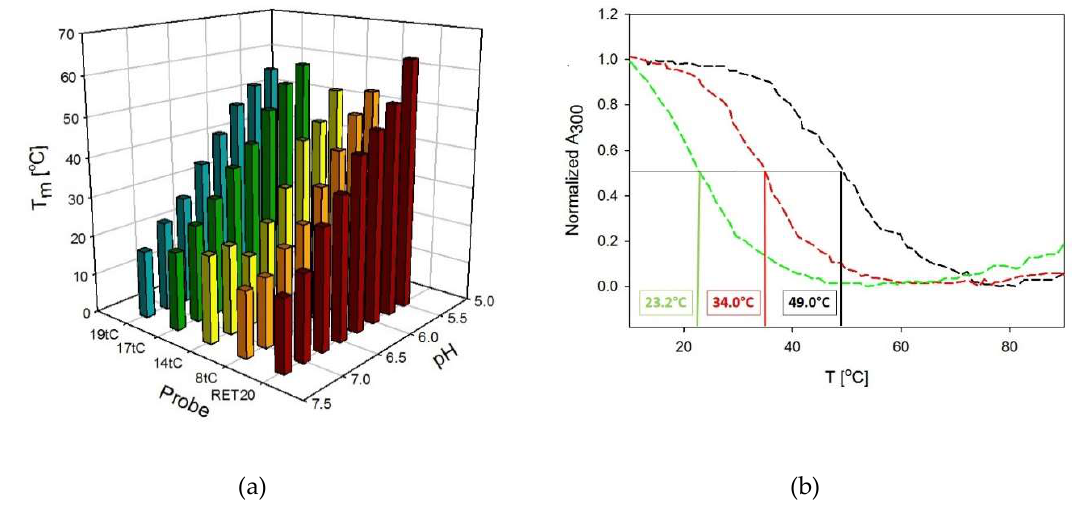
Figure 2. ( a ) Thermal melting temperatures for tC-modified probes: 8tC (orange), 14tC (yellow), 17tC (green), 19tC (blue), and unmodified 5′-(C 4 G) 3 C 4 A-3′ sequence (black) plotted against pH. All values and standard errors are presented numerically in Table 2; ( b ) Denaturation normalized profiles of the 8tC probe recorded at 300 nm at three different pH values: pH 5.75 (green dash line); pH 6.25 (red dash line); pH 6.75 (black dash line). The presented curves are obtained during heating.